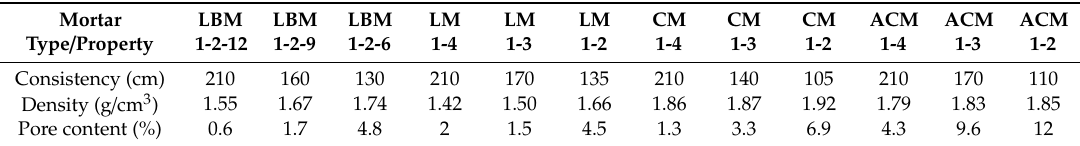
Table 2. Properties of mortar in its fresh